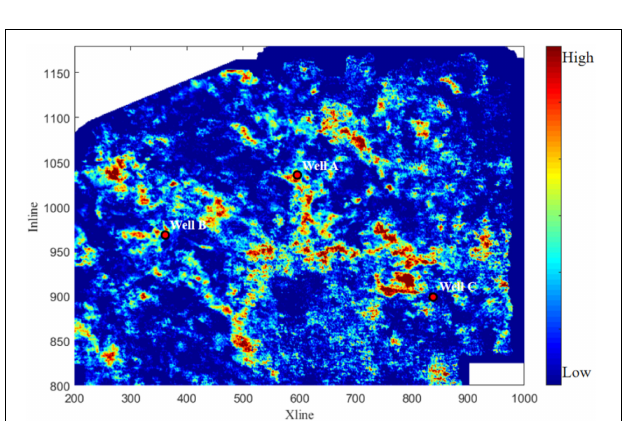
FIGURE 13 | Horizontal slice of the P-wave velocity dispersion attribute